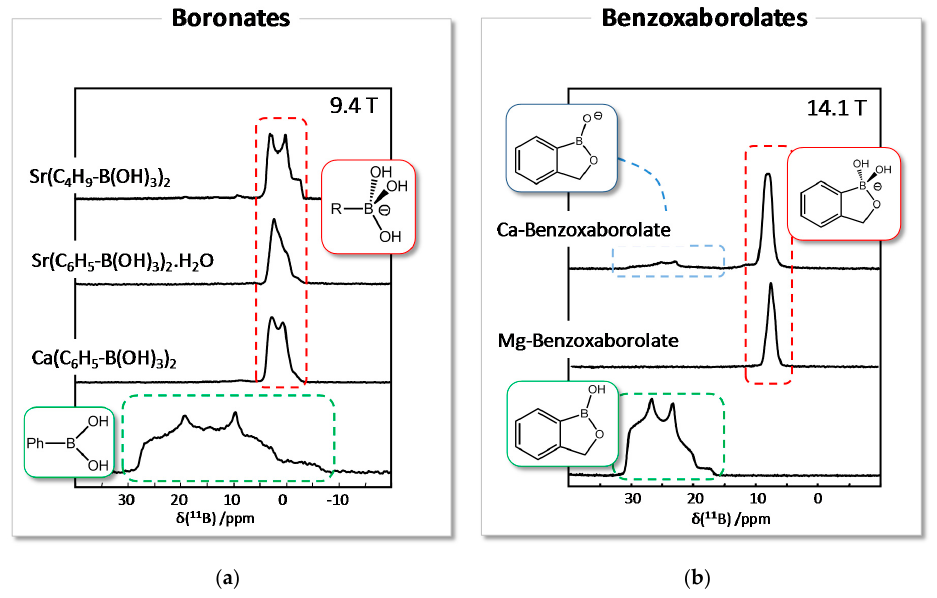
Figure 9. 11 B solid state NMR spectra of alkaline-earth metal boronates ( a ) and benzoxaborolates ( b ), as well as for the corresponding boronic acid and benzoxaborole. The spectra shown here were recorded under MAS at two different magnetic fields (9.4 T for boronic acids, vs. 14.1 T for benzoxaboroles), and present second order quadrupolar lineshapes. Adapted with permission from [27] (copyright American Chemical Society, 2015).